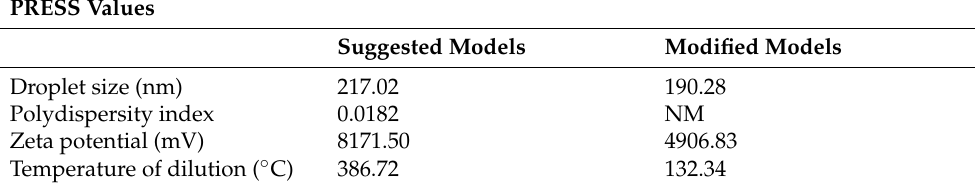
Table 6. PRESS values of suggested and modified